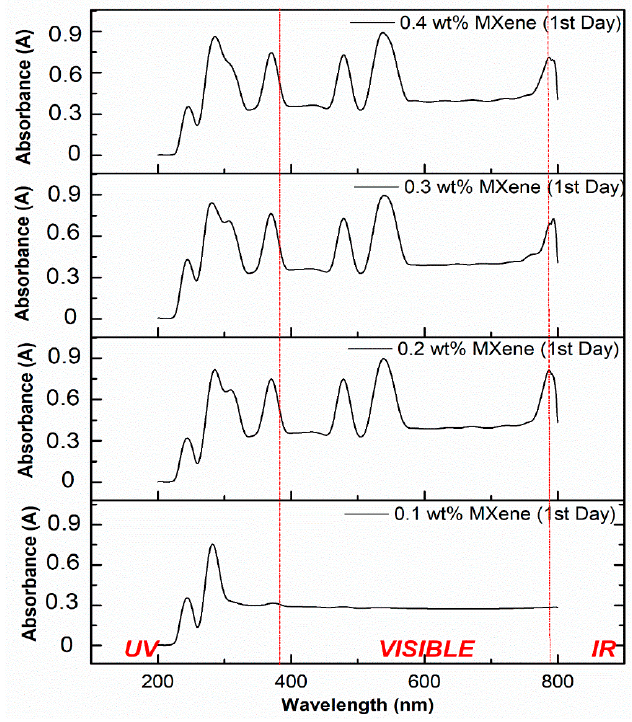
Appl. Sci. 2020 , 10 , x FOR PEER REVIEW Figure 8. Absorption spectra of ionanofluids with di ff erent weight concentrations on the first day. Figure 8. Absorption spectra of ionanofluids with different weight concentrations on the first day.